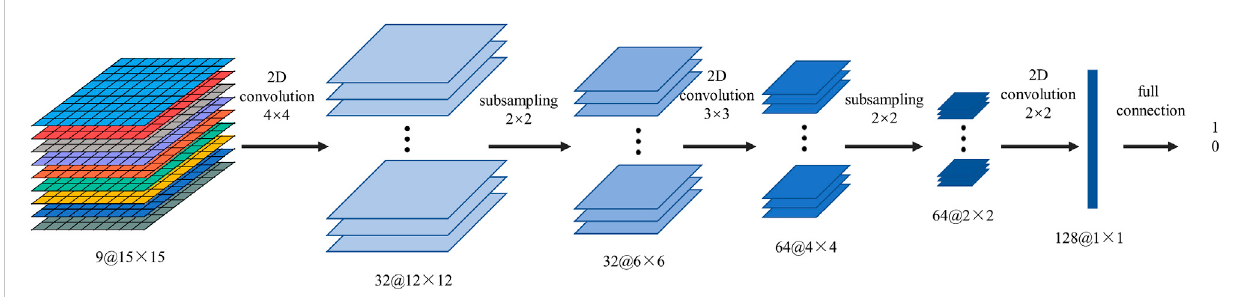
FIGURE 5 The structure of the CNN model.